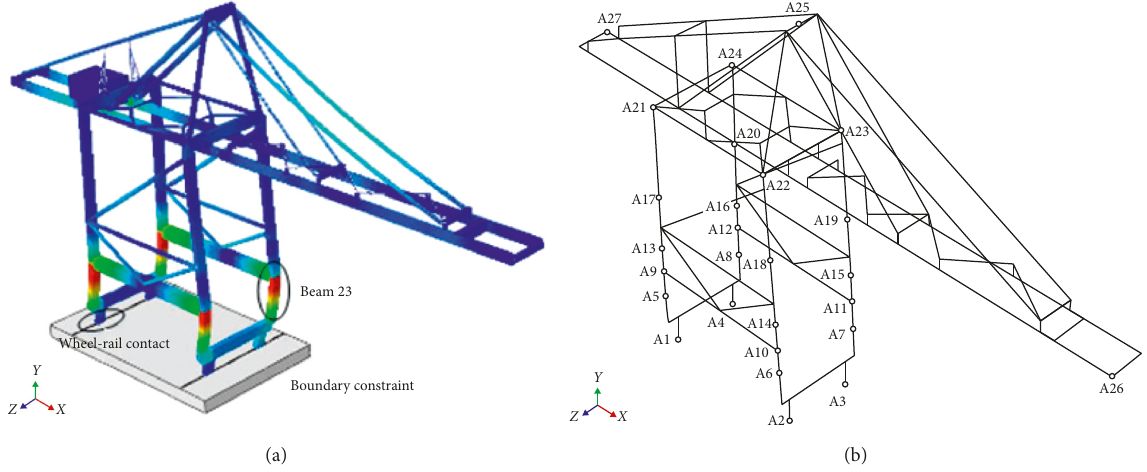
Figure 3: Finite element model and the layout of measuring points of the QCC. (a) Simulation model. (b) Acceleration monitoring point. 0.81.01.21.41.6